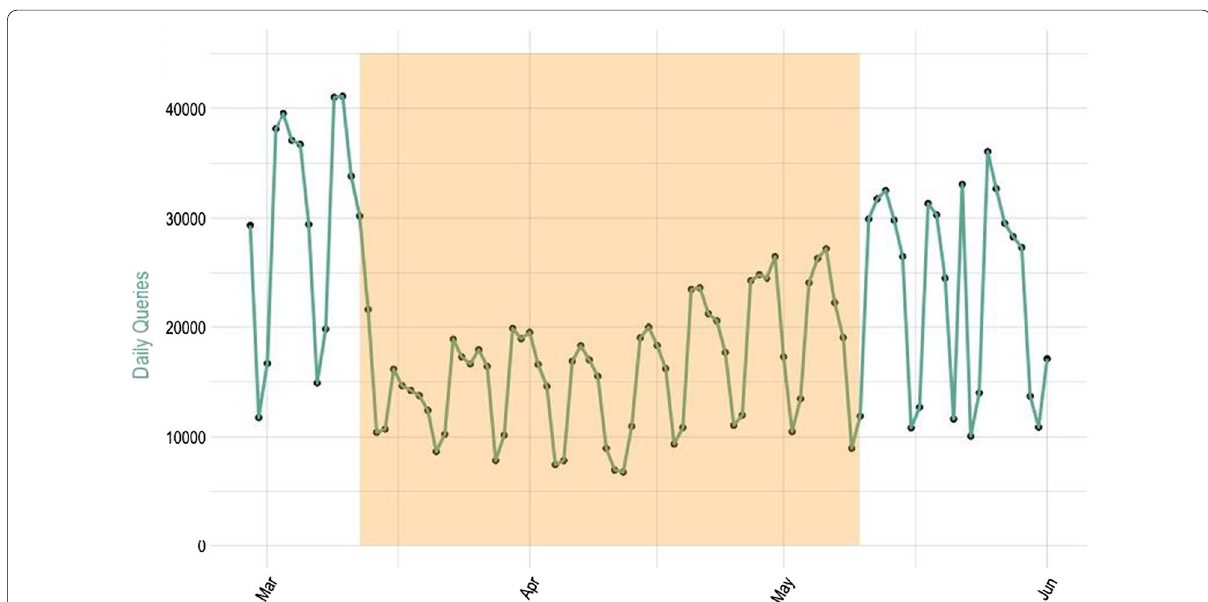
Fig. 7 First shutdown, daily queries, Feb 28–Jun 01, 2020. Green solid line connects for illustration purposes the daily queries (black points). Yellow shaded area represents the time between 13.03 and 11.05.2020